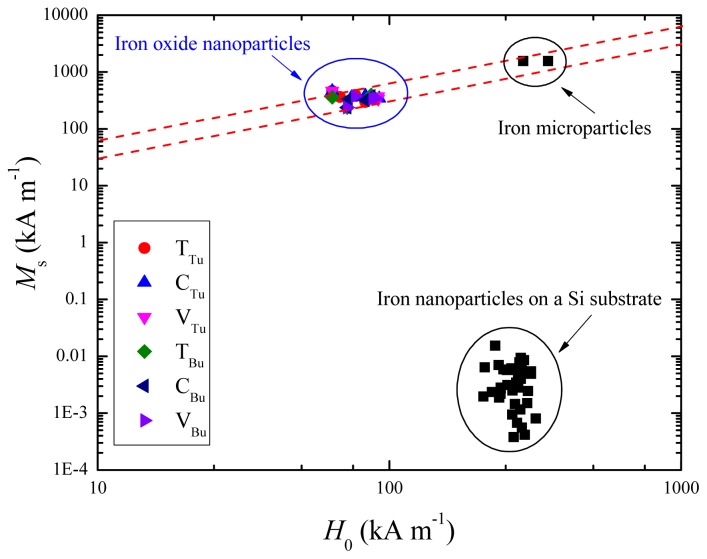
A scatter plot of Msversus H0 for all the magnetite nanoparticles.